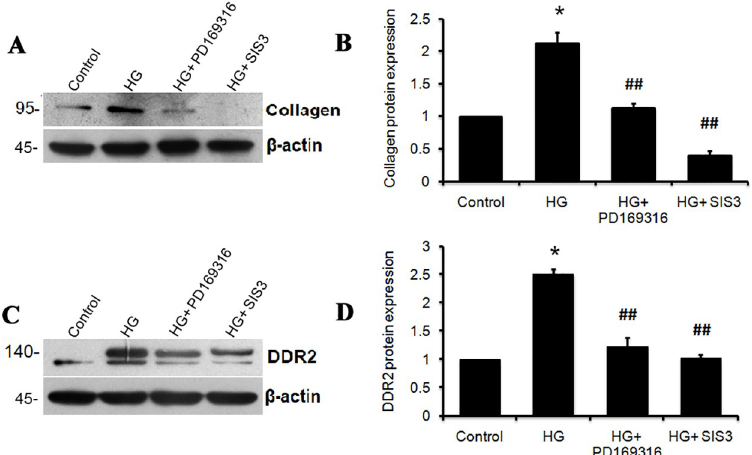
Fig 3. SMAD2/3 inhibition attenuates HG-induced DDR2 and collagen expression. Sub-confluent quiescent cultures of vascular adventitial fibroblasts in M199 were pre-treated with SMAD2 inhibitor, PD169316, and SMAD3 inhibitor, SIS3, for 1 h and subsequently with HG for 12 h. Post-HG treatment, protein was isolated and subjected to western blot analysis for detection of: ( A and B) Collagen type 1 alpha 1; � p < 0.05 vs. control, ##p < 0.01 vs. HG (One- way ANOVA p < 0.05) and ( C and D) DDR2; � p < 0.05 vs. control, ##p < 0.01 vs. HG. (One-way ANOVA p < 0.05). β - actin was used as loading control. Data are representative of three independent experiments, n = 3. Error bars represent SD.